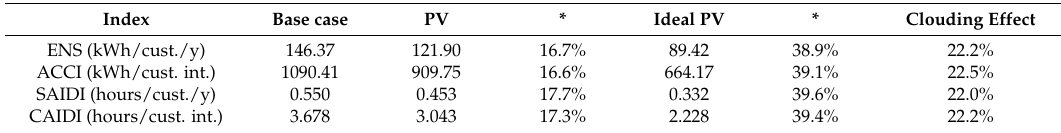
Table 2. Impact of clouding effect on reliability indices.